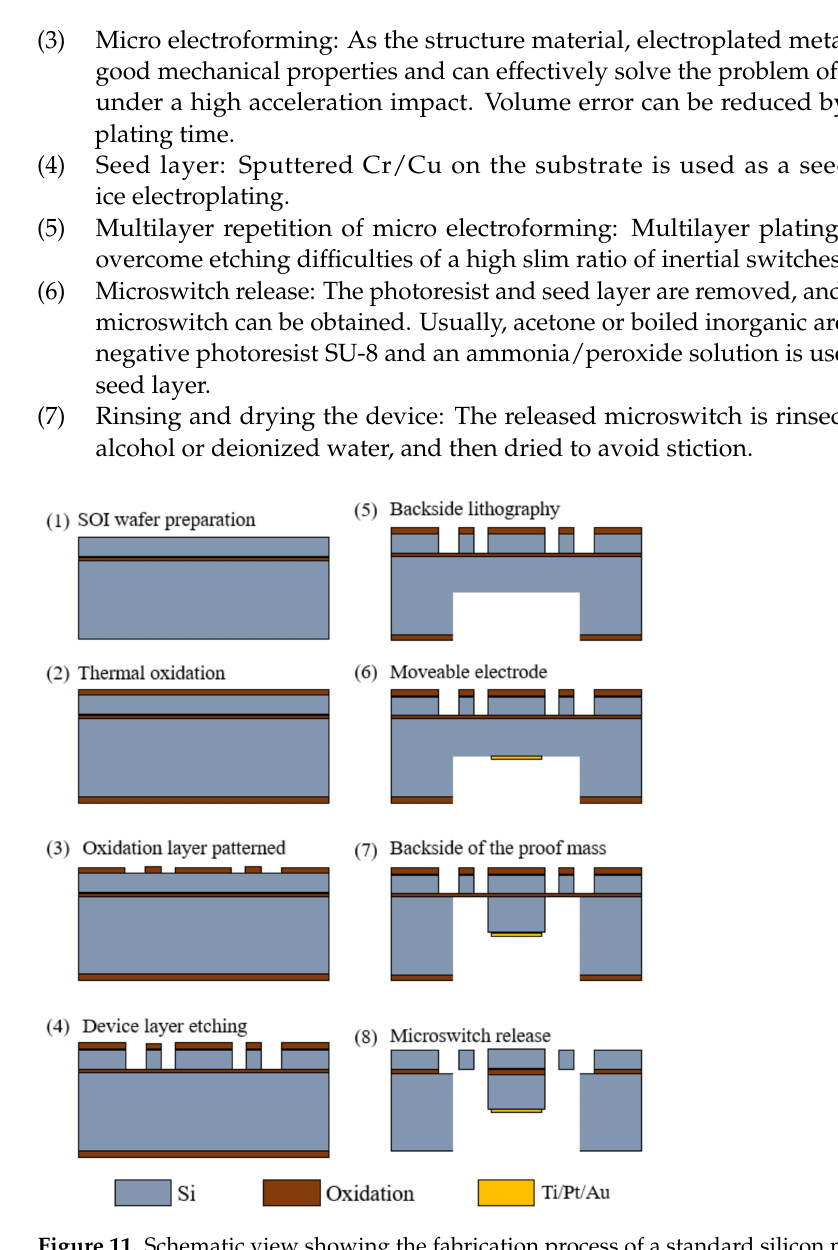
Figure 11. Schematic view showing the fabrication process of a standard silicon